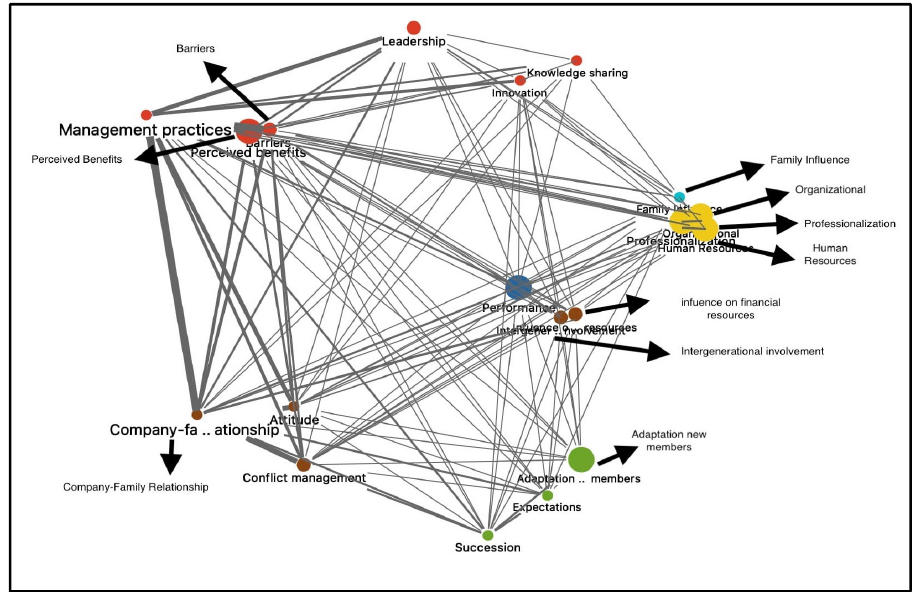
Figure 3. Occurrence and list of emerging themes. Source: elaborated by the authors.